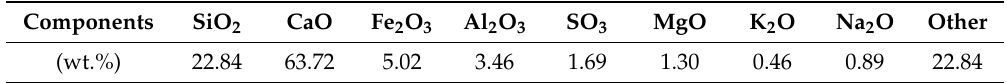
Figure 1. Schematic diagram for the synthesis of DPAM and cement core. Table 1. Composition of Class-G oil well cement.